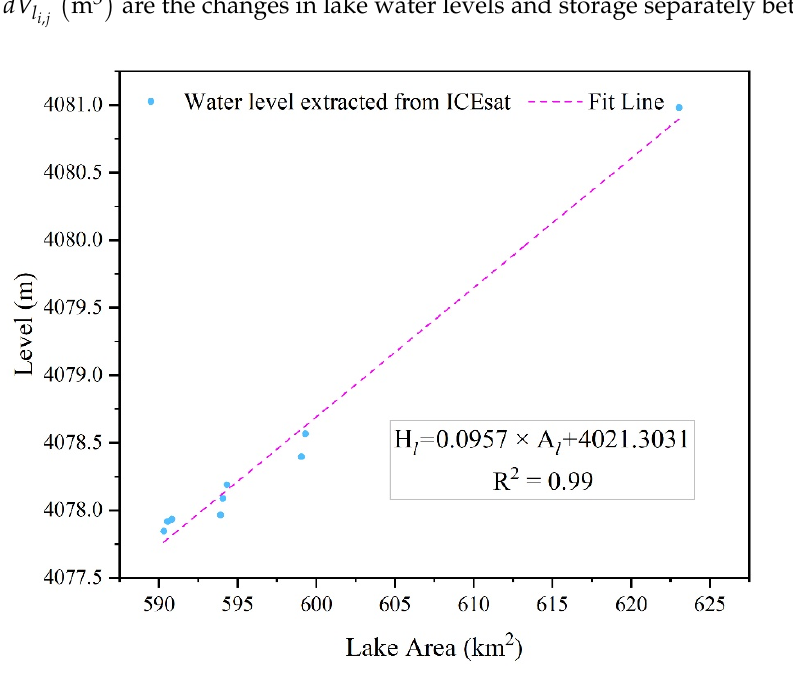
Figure 2. Relationship between the water level of Hala Lake and its lake area.